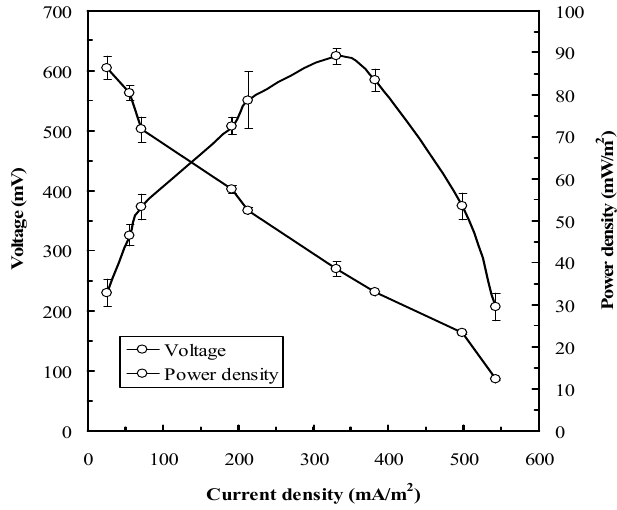
Figure 2. Polarization and power curves obtained from the MFC biosensor inoculated with O. anthropi YC152 during the stable phase of power generation (operating temperature: 35 °C, anolyte: 1/1000 LB, catholyte: 50 mM phosphate and 100 mM NaCl).